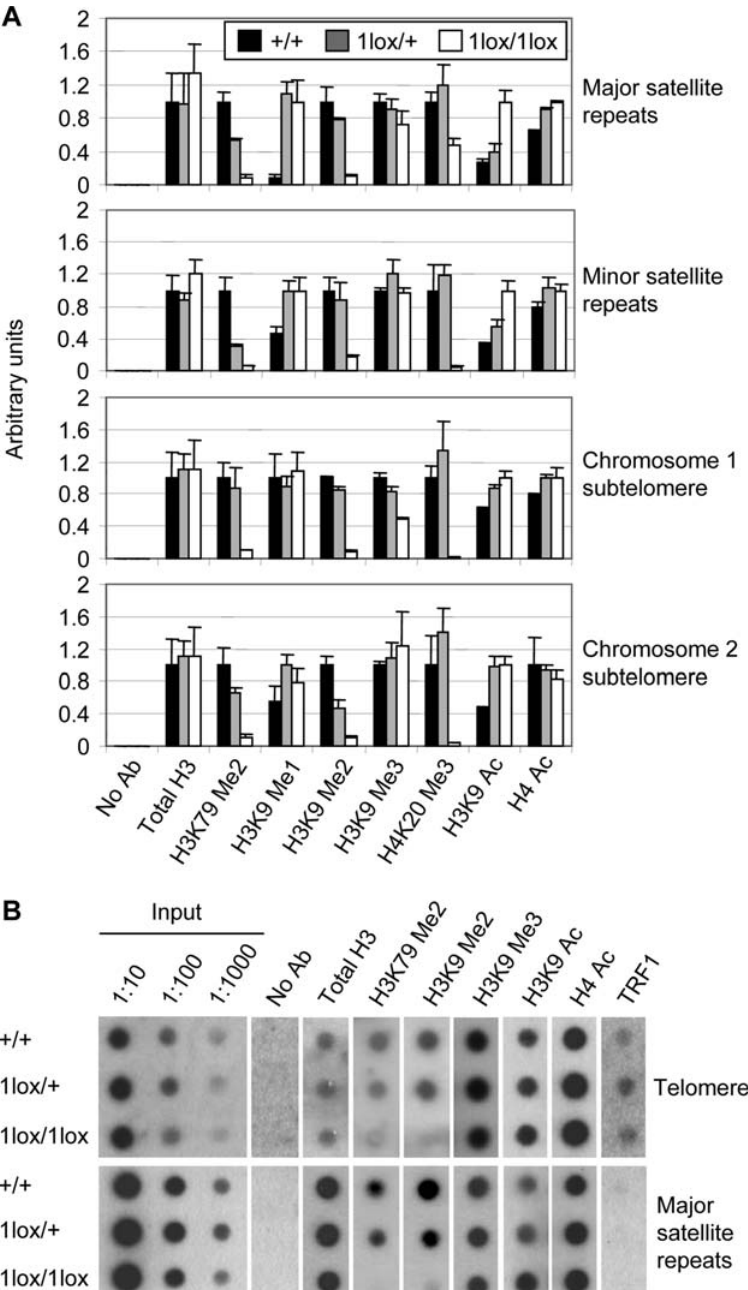
Figure 6. Changes of heterochromatin structure in Dot1L -deficient ES cells. (A) Quantitative real-time PCR results using DNA from Dot1L mutant and wild-type ES cells immunoprecipitated with antibodies specific for the indicated histone modifications or without an antibody (No Ab) and normalized using input DNA values. PCR primers specific for major satellite repeats, minor satellite repeats, the subtelomere region of chromosome 1 or the subtelomere region of chromosome 2 were used. (B) Dot blot analysis of ChIP DNA using either a telomere-specific probe or a major satellite repeat-specific probe. Input DNA at 1:10, 1:100 and 1:1000 dilutions was used as a positive control. DNA precipitated from 2.5 6 10 6 cells were used for each assay. telomeres [20,21,23,26,27]. Based on the observation that H3K9 tri- methylation at telomeres and centromeres, suggesting that Dot1L methylation by the Suv39h methyltransferases is required for the functions upstream of the Suv20h enzymes. Given that H3K9 tri- induction of H4K20 tri-methylation by the Suv4-20h methyltrans- methylation shows no obvious alterations in Dot1L -deficient cells, it is ferases at pericentric heterochromatin, a sequential model of possible that Dot1L acts in parallel or downstream of the Suv39h chromatin assembly at constitutive heterochromatin has been enzymes. Interestingly, despite the relatively normal levels of H3K9 proposed in which Suv4-20h enzymes act downstream of the tri-methylation, H3K9 di-methylation is severely reduced at Suv39h enzymes [26]. Dot1L -deficient cells show loss of H4K20 tri- constitutive heterochromatin in the absence of Dot1L. Because the